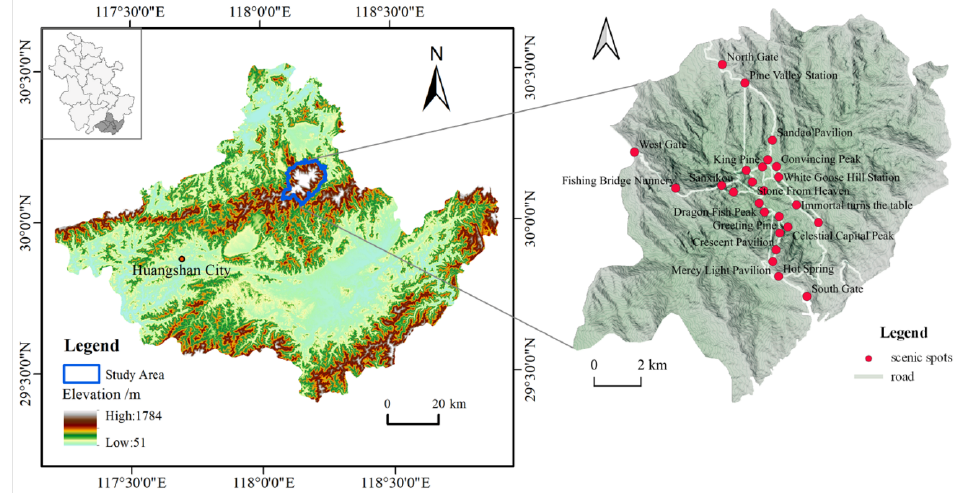
Figure 1. Schematic diagram of Huangshan